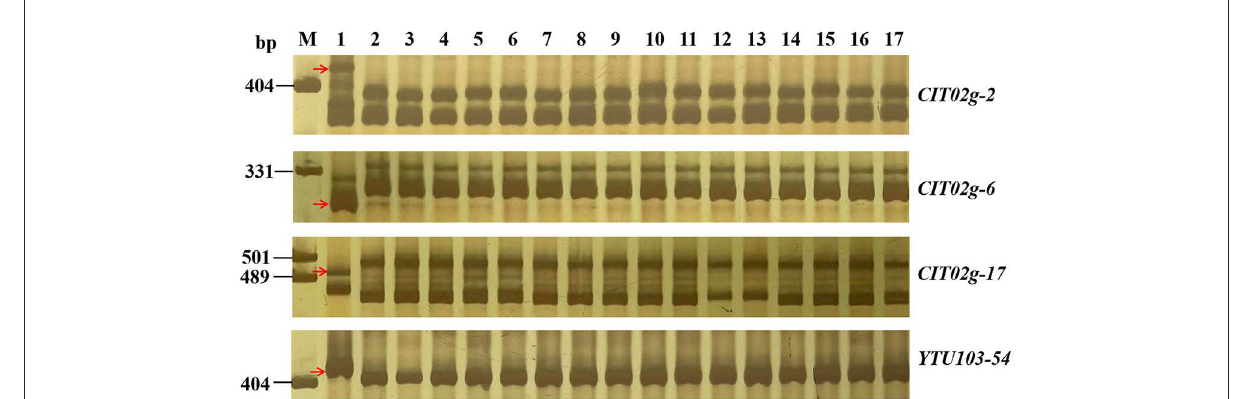
FIGURE6 Amplification patterns of pmYN99102 -linked markers CIT02g-2 (A) and CIT02g-6 (B), CIT02g-17 (C) and YTU103-54 (D) in Yannong 99102-06188 (YN99102), Jinhe13–205 (JH13–205), and 15 wheat cultivars/breeding lines susceptible to powdery mildew. M, DNA marker pUC18 Msp I; lanes 1 and 2, YN99102 and JH13–205; and lanes 3–17: Shannong 1,538, Hanmai 13, Huaimai 0,226, Zhoumai 27, Xinong 979, Lumai 185, Zhongyu 1,311, Jimai 268, Tainong 1,014, Jimai 229, Jimai 21, Jimai 20, Daimai 2,173, Zhoumai 1,751, Jinan 17. The white arrows indicate the polymorphic bands in